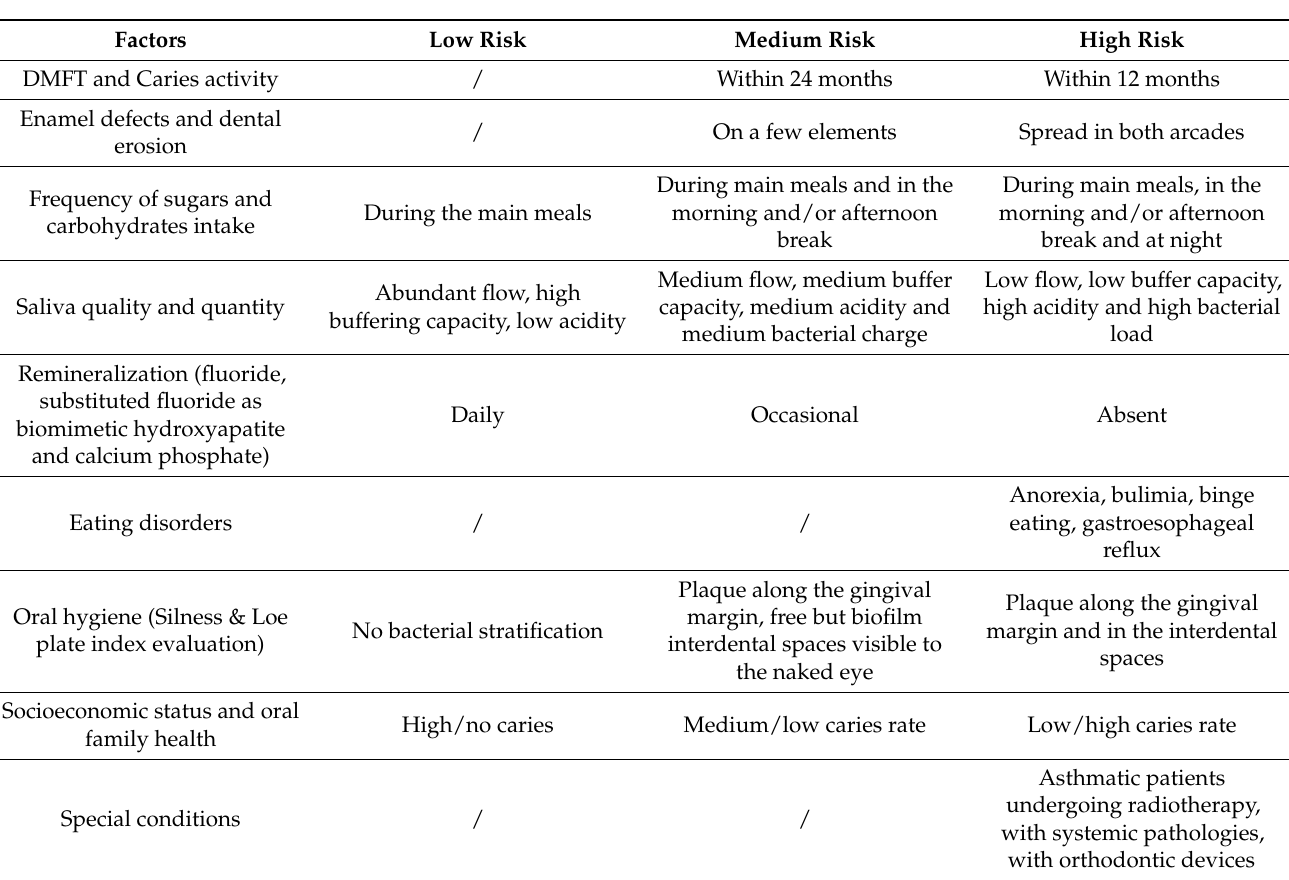
Table 3. Determination of the caries